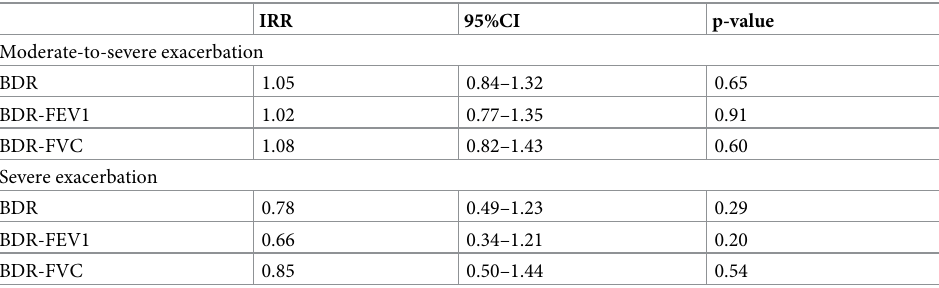
Table 3. Risk of exacerbation according to BDR.